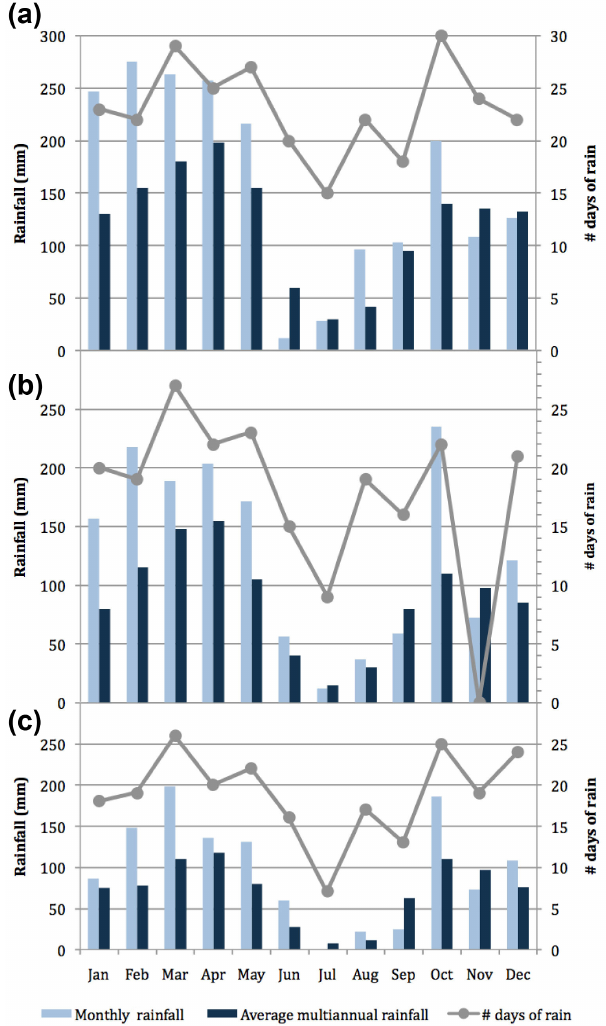
Figure 5. Total monthly rainfall, average multiannual rainfall (data since 1975) and number of days with rain per month (higher than 0.1mm) of the three meteorological stations closest to El Trébol (a) Izobamba: latitude: − 0.366089, longitude: − 78.555061; altitude: 3085.00ma.s.l.; (b) Iñaquito: latitude: − 0.175000; lon- gitude: − 78.485278; altitude: 2789.12; (c) La Tola: latitude: − 0.231667; longitude: − 78.370333, altitude: 2480ma.s.l. From INAHMI